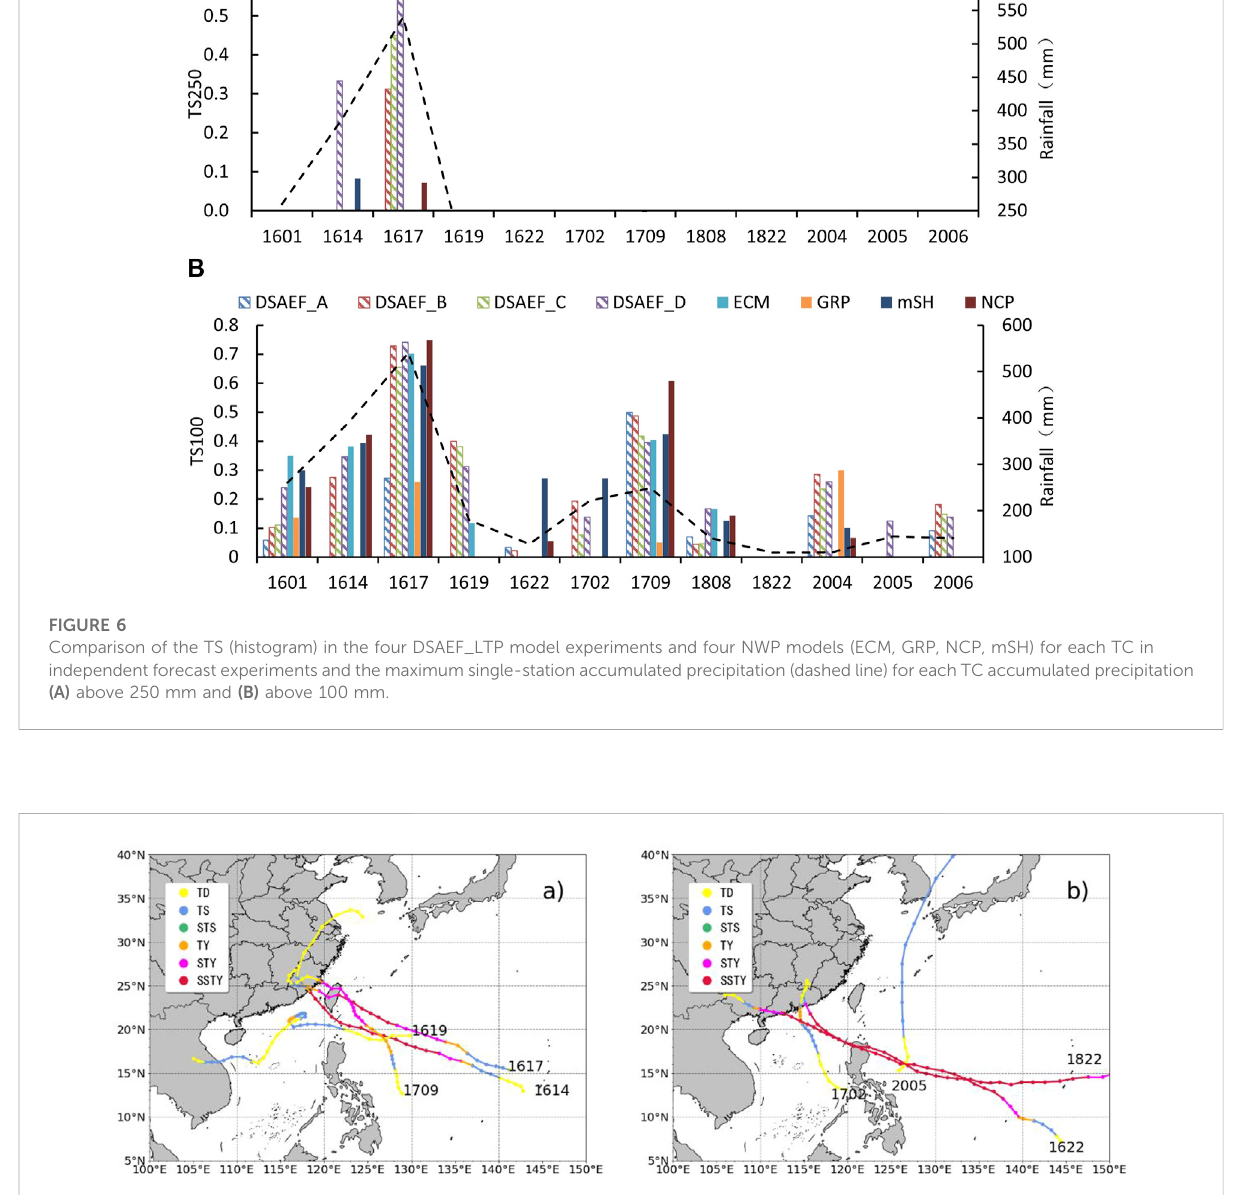
FIGURE 7 The TC tracks and intensity of (A) the top four TCs with higher TSsum and (B) the bottom four TCs with lower TSsum in independent forecast experiments simulated by the DSAEF_D